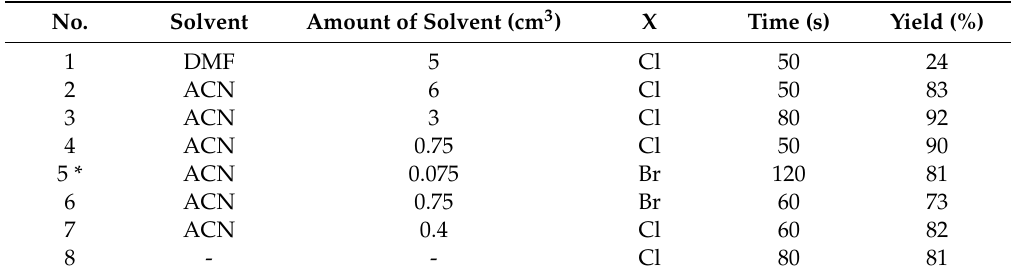
Table 1. Synthesis 2-(3-halopropyl)[1,2,4]triazolo[4,3-a]pyridin-3(2 H )-one ( 3a / b )—0.01 mol of 1,2,4-